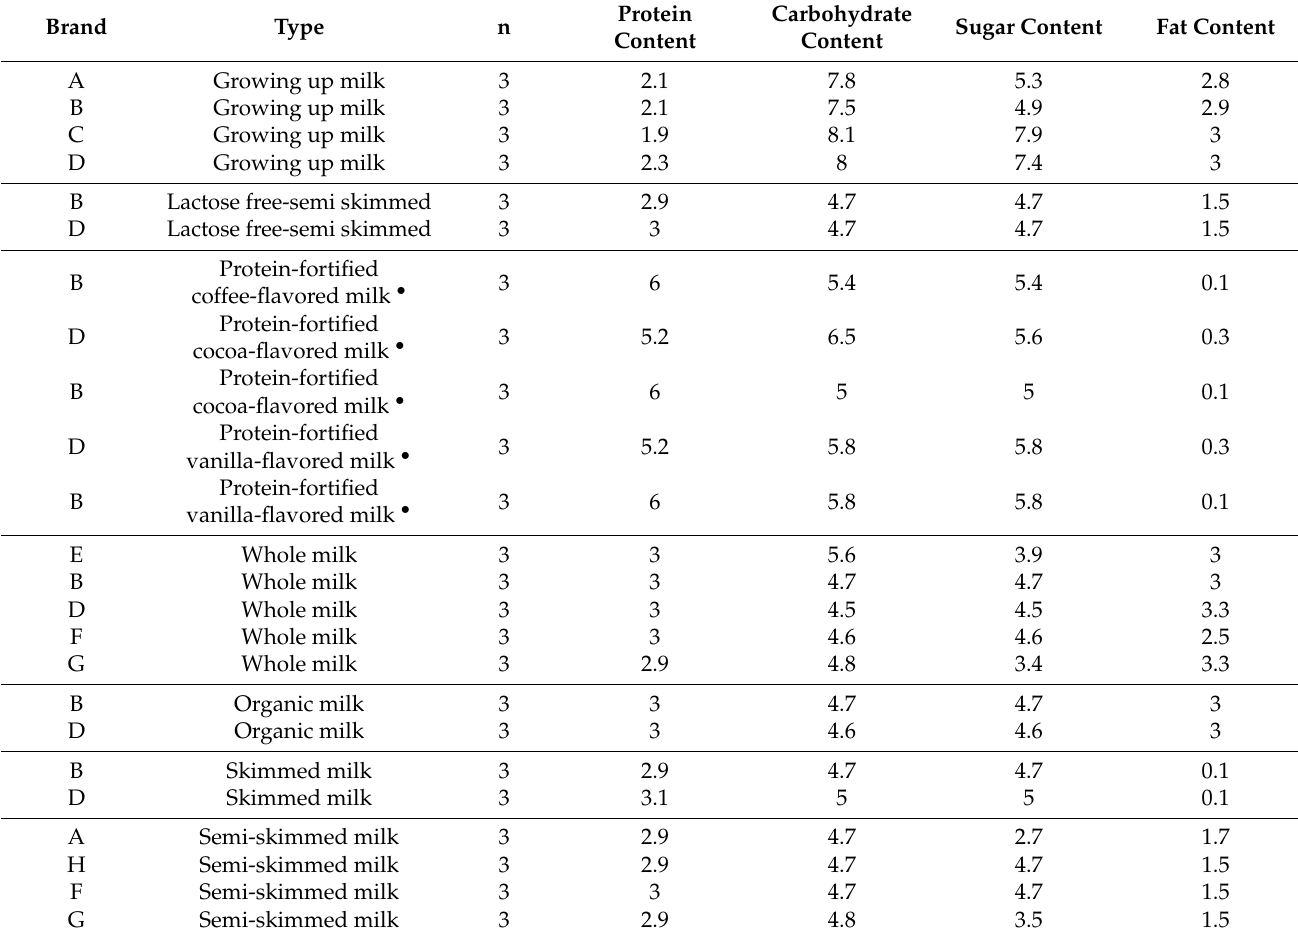
Table 1. The nutrition facts label of milk samples according to the manufacturer’s